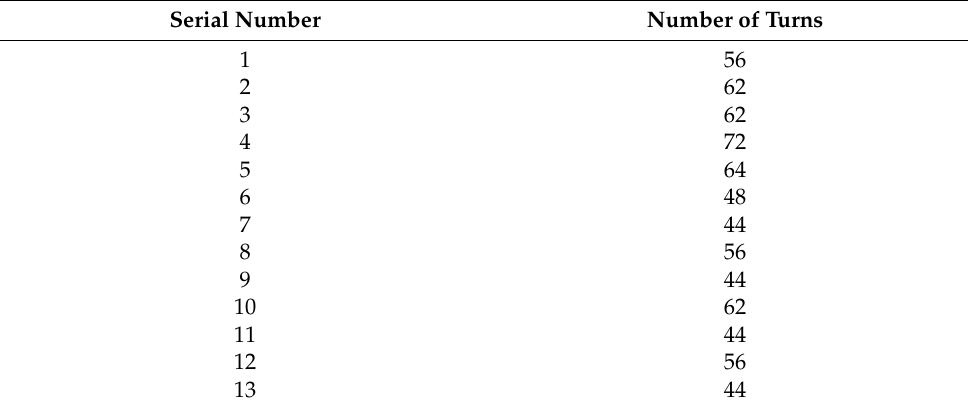
Table 5. The number of turns for each scheme.